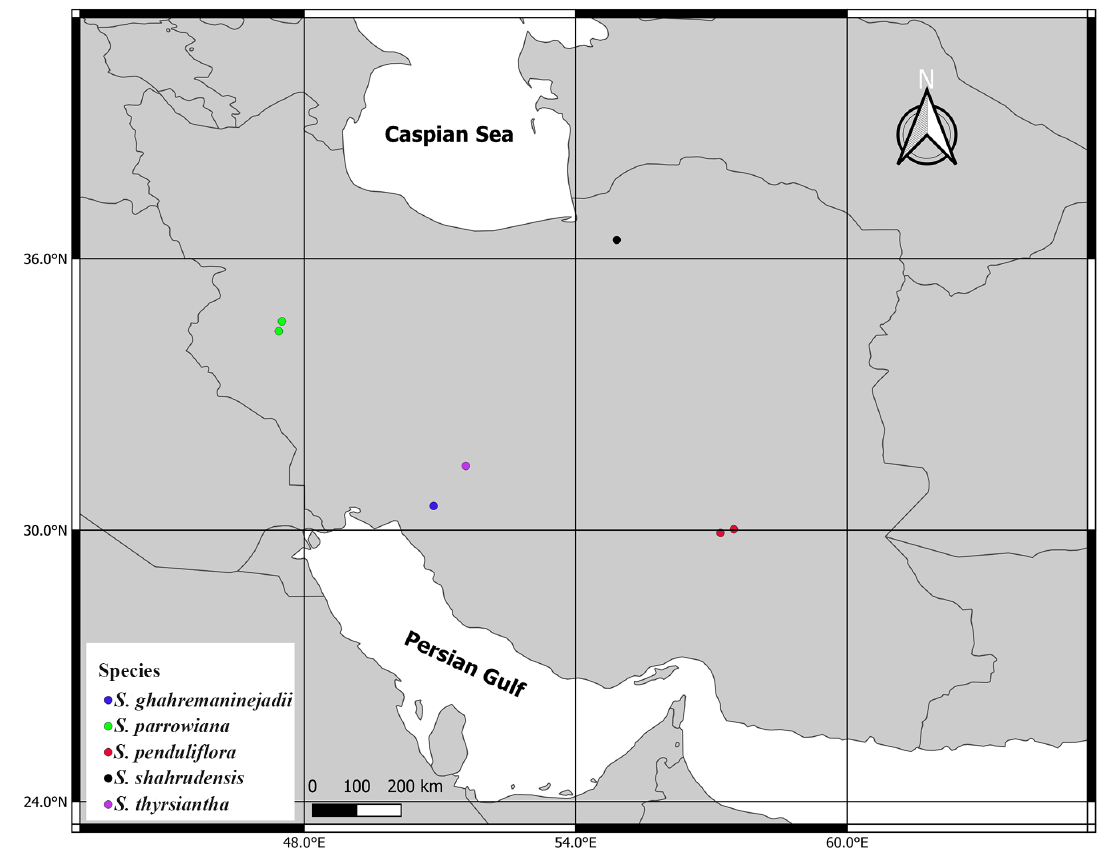
Fig. 3. Distribution map of S. ghahremaninejadii Hoseini & Assadi (blue dot), S. parrowiana Boiss. & Hausskn. (green dots), S. penduliflora F.Jafari, Keshavarzi & Doostm. sp. nov. (red dots), S. shahrudensis Rech.f. (black dot), and S. thyrsiantha F.Jafari, Mirtadz. & Keshavarzi sp. nov. (purple dot). The map was made with QGIS ver.